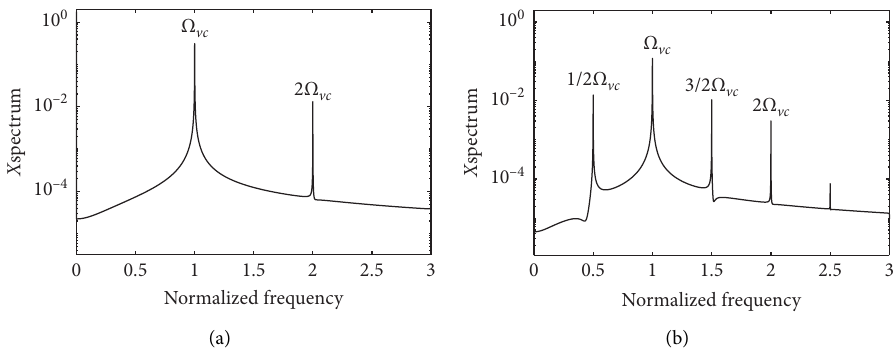
Figure 6: Power spectra of X ( τ ) of (a) period-1 and (b) period-2 motions of X ( τ ) for δ